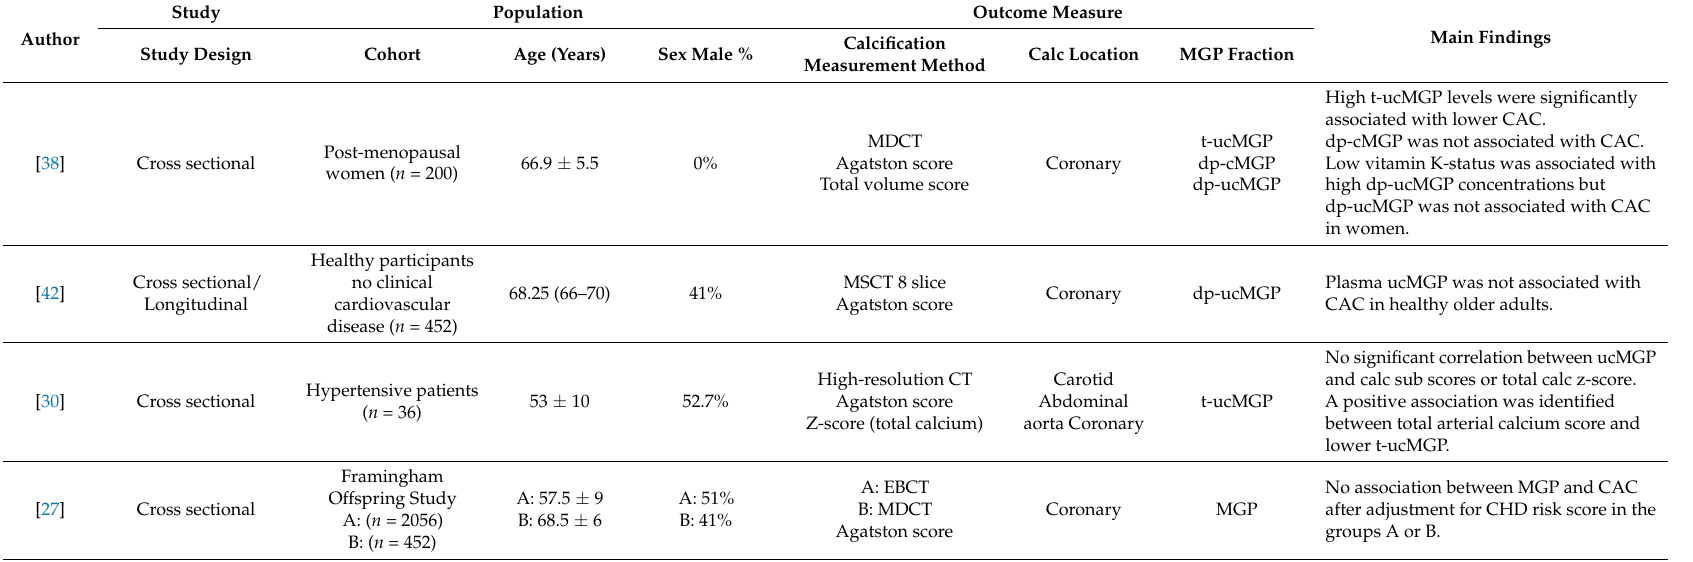
Table 6. Association between MGP fractions and vascular calcification in a healthy population